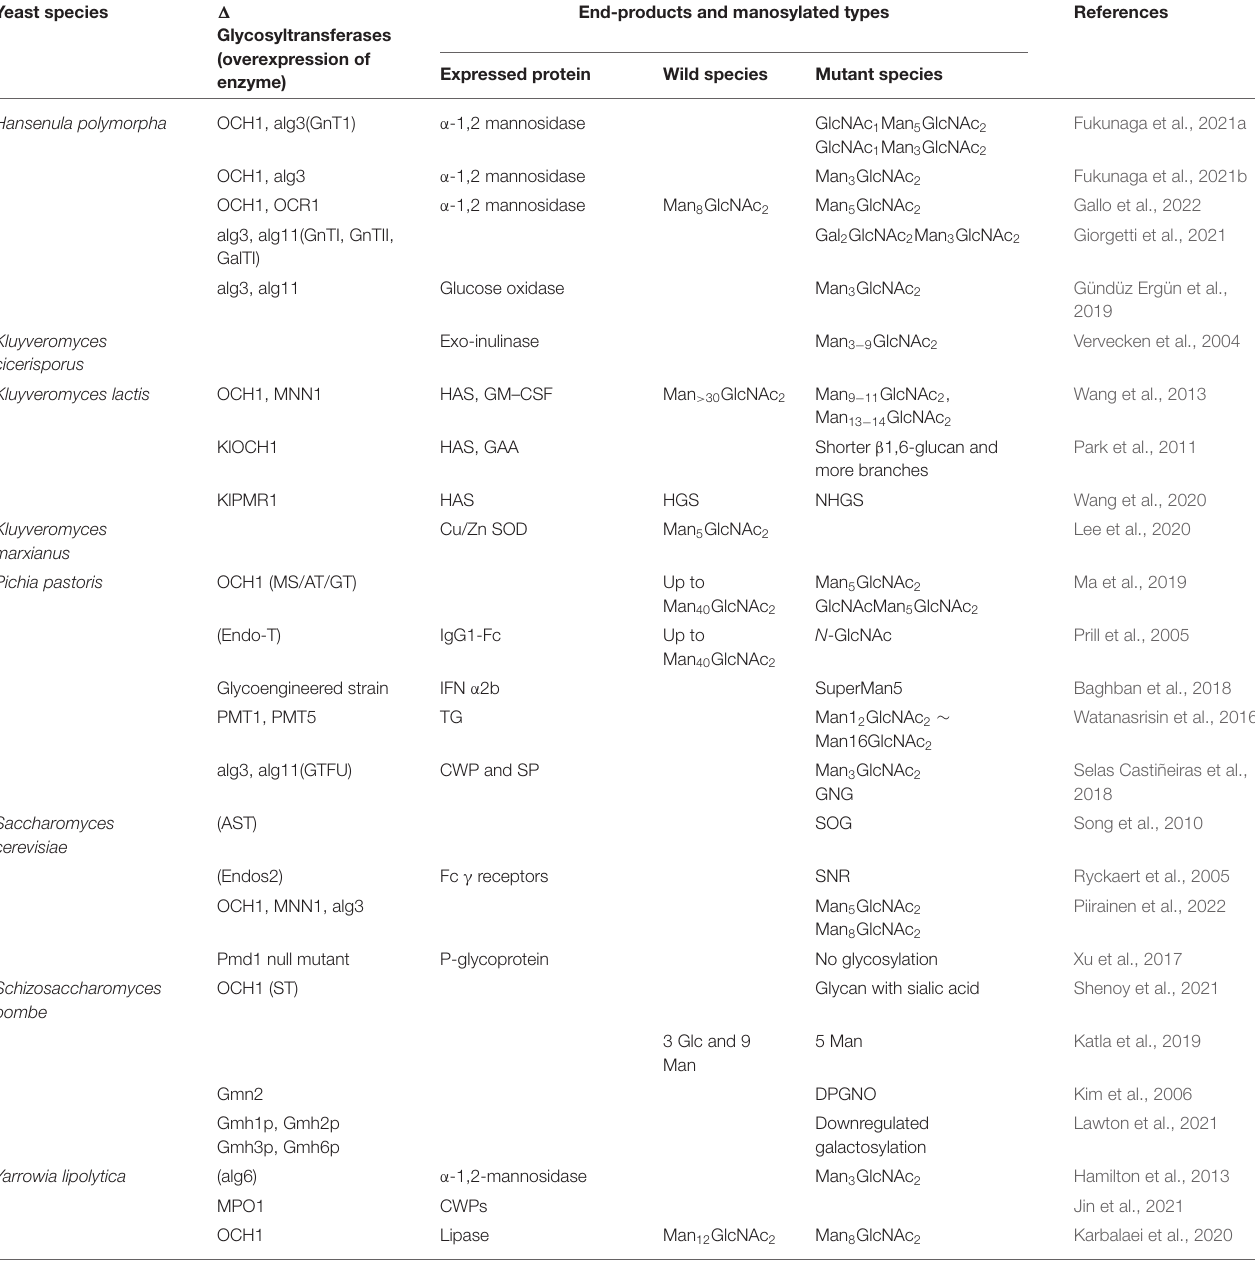
TABLE 1 | Humanized glycoprotein expression in genetically modifying yeasts or naturally yeasts. Yeast